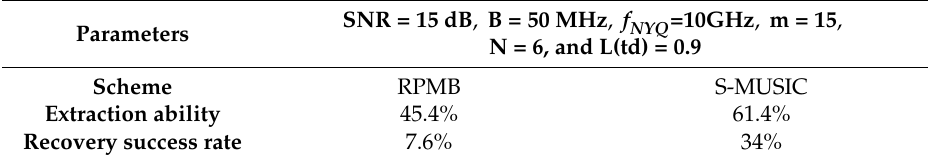
Table 2. The comparison of the extraction and reconstruction ability.